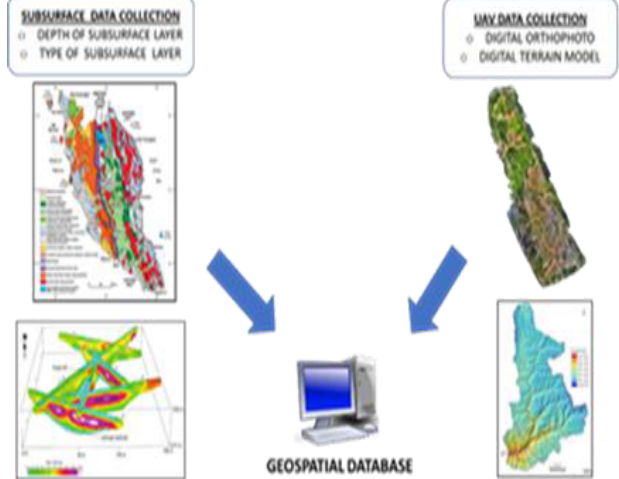
Framework in development of groundwater exploration